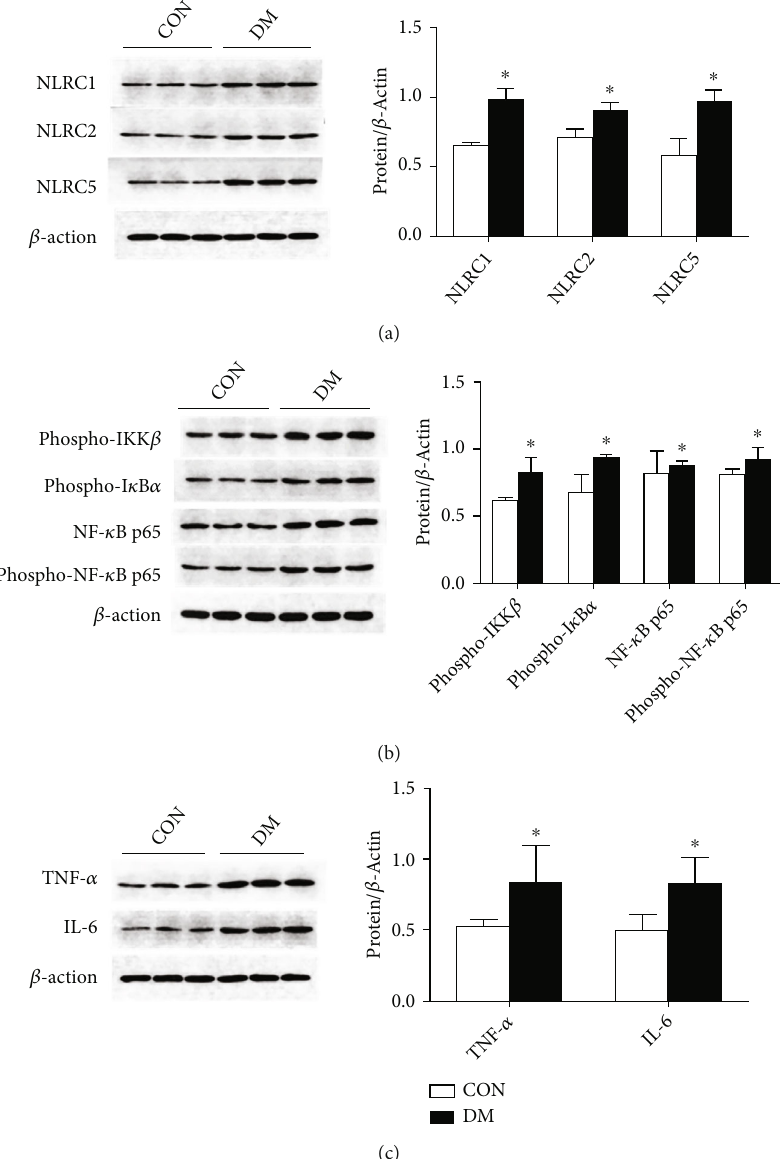
Figure 4: Expression of the NLRC subfamily and the downstream NF- κ B signaling pathway was analyzed by Western blots in kidney tissues from diabetic minipigs. (a) Detection of NLRC subfamily members ’ expression by Western blots and semiquantitative analysis of the expression levels of the NLRC subfamily members. (b) Detection of the NF- κ B signaling pathway by Western blots and semiquantitative analysis of the expression levels of the NF- κ B signaling pathway. (c) Detection of in fl ammatory factor (TNF- α and IL-6) expression by Western blots and semiquantitative analysis of the expression levels of in fl ammatory factors (TNF- α and IL-6). Protein expression data are presented as the means ± SD . ∗ P < 0 : 05 versus